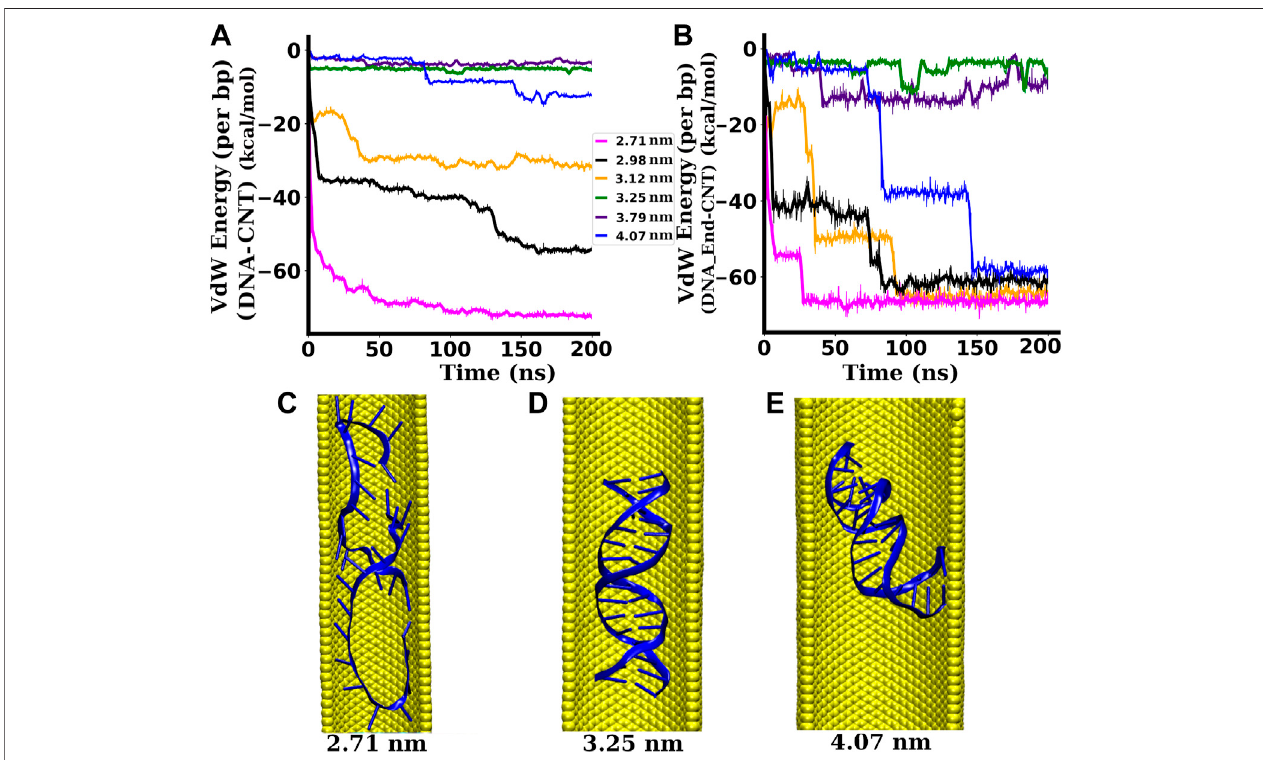
FIGURE 8 | Interactions between the dsDNA and the SWCNT wall. (A) Interaction (VdW) energy per bp between the dsDNA and the SWCNT wall. (B) Interaction (VdW) energy per bp between the end base pairs ofthe dsDNA and theSWCNT wall. (C) Snapshotof thedsDNA inside aSWCNT ofdiameter 2.71 nm ((20,20) chirality indices). (D) Snapshot of the dsDNA inside a SWCNT of diameter 3.25 nm ((24,24) chirality indices). (E) Snapshot of the dsDNA inside a SWCNT of diameter 4.07 nm ((30,30) chirality indices). When the dsDNA gets space to bend, the hydrophobic end regions of the dsDNA get attracted towards the hydrophobic surface of the SWCNT while the central region remains nearly unaffected (Zhao and Johnson,